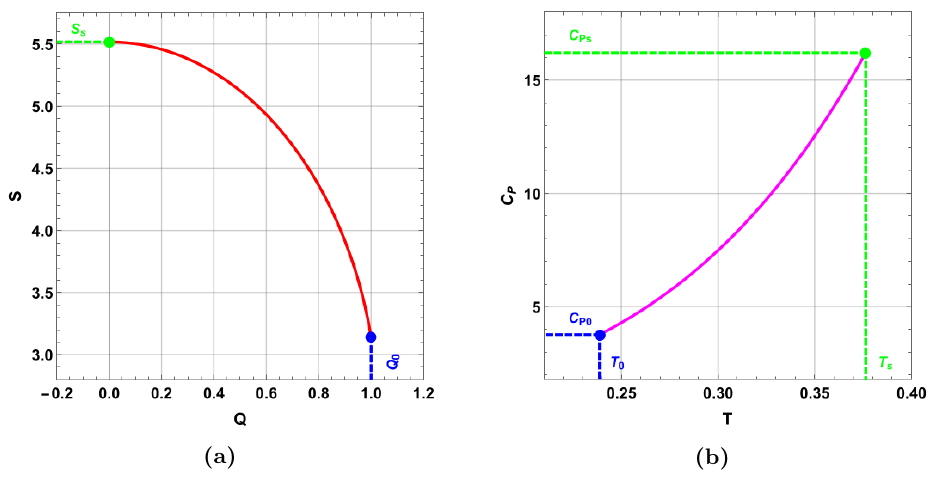
Figure 24. (a) Entropy as a function of black hole electric charge during an isobar absorption of 10 3 particles with a fixed electric charge dQ = − 0 . 001 . (b) Heat capacity at constant pressure in terms of black hole temperature during an isobar absorption of 10 3 particles with a fixed electric charge dQ = − 0 . 001 . The initial conditions are Q 0 = 1 , l = 1 , M 0 = 1 . 5 , r h = 1 and D = 4 .